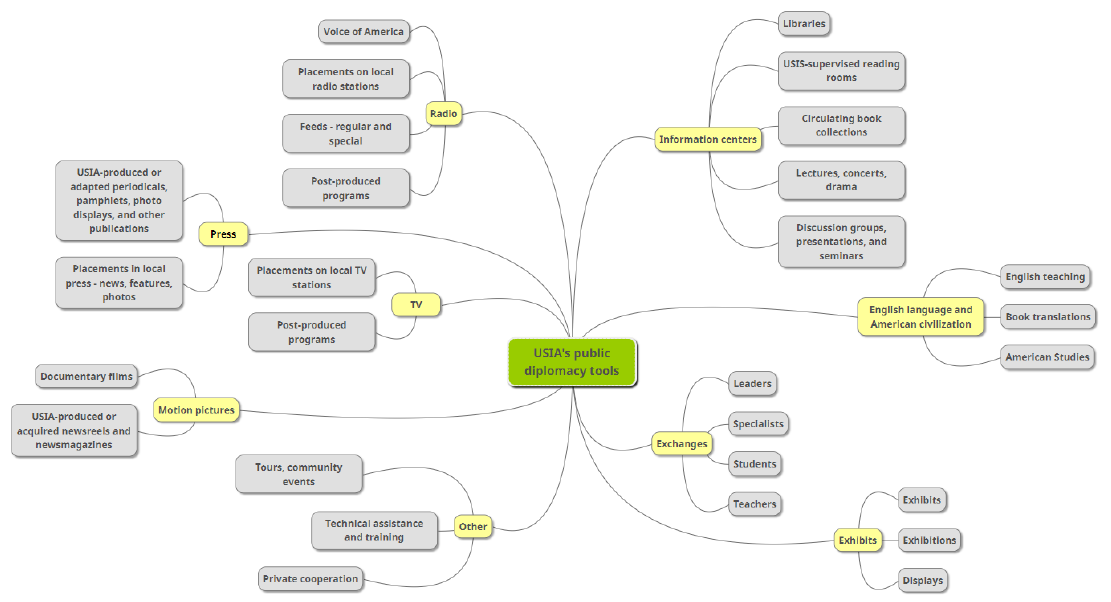
Figure 1. USIA’s Public Diplomacy Tools. Source: Author’s figure drawn with the Mindmup software based on Henderson (1969).